Question: Looking at the figure, what chart type is it?
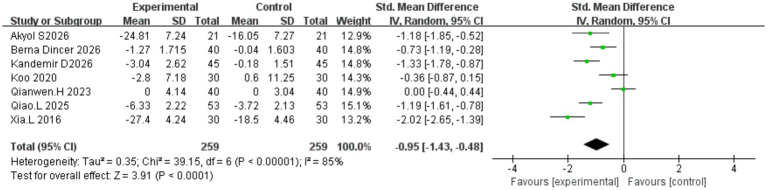
Answer: forest